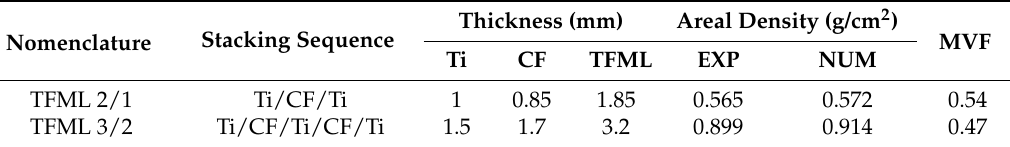
Figure 1. Ballistic impact experiment ( a ) Illustration of 3/2 fibre metal laminate (FML), and ( b ) Experimental set up. Table 1. Configurations of the titanium-based fibre metal laminate (TFML) Panel.